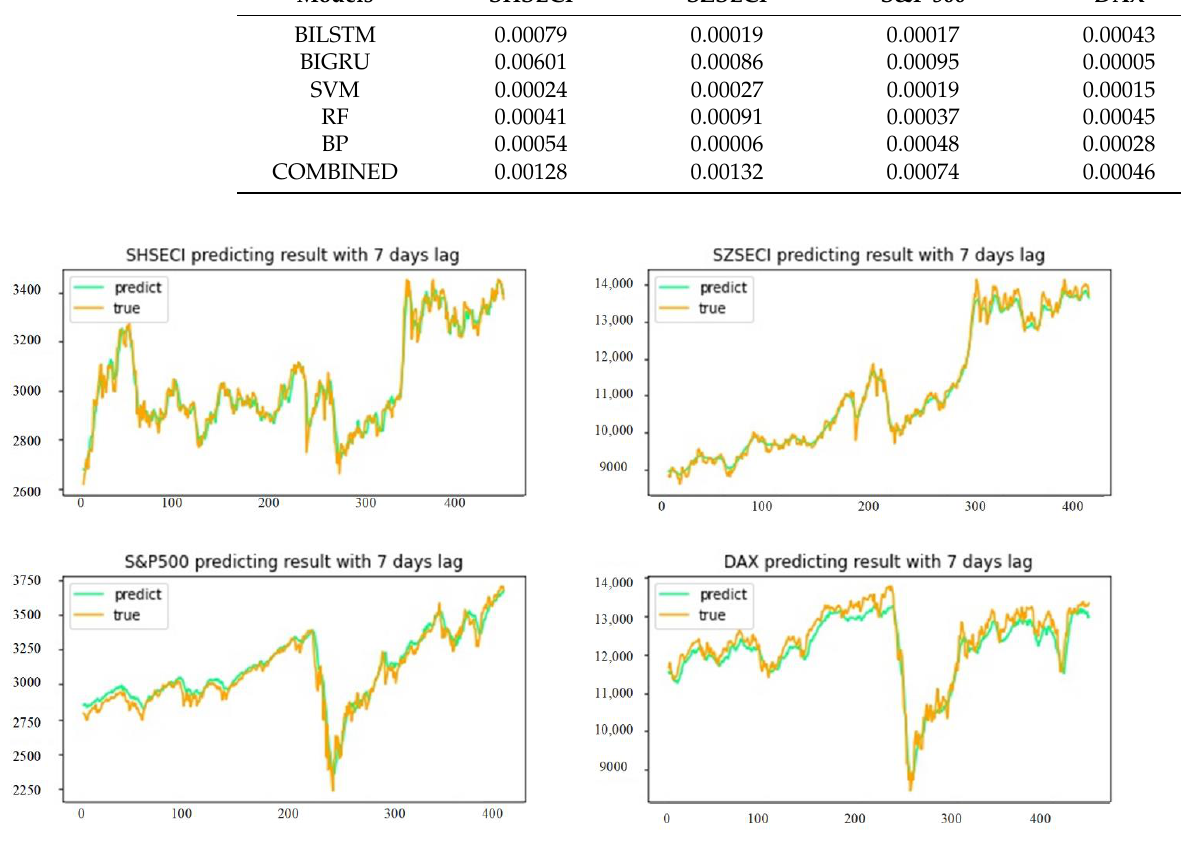
Figure 7. Prediction results of four stock indices with 7-day lag.